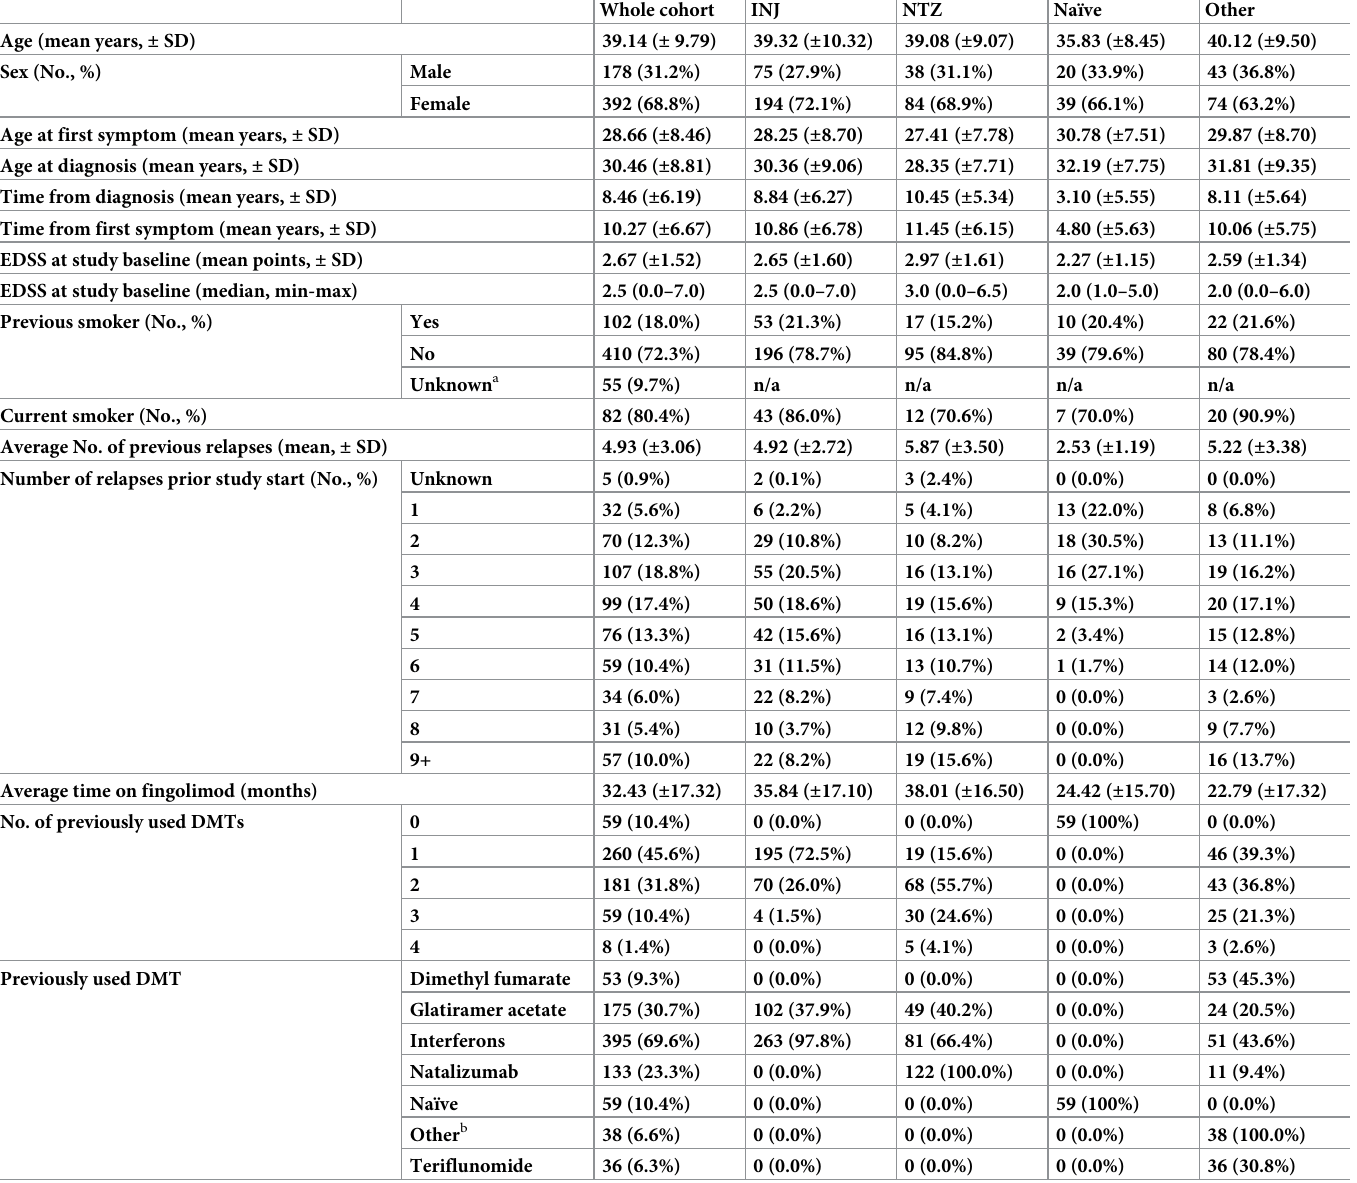
Table 1. Baseline demographic and clinical characteristics for the intention to treat